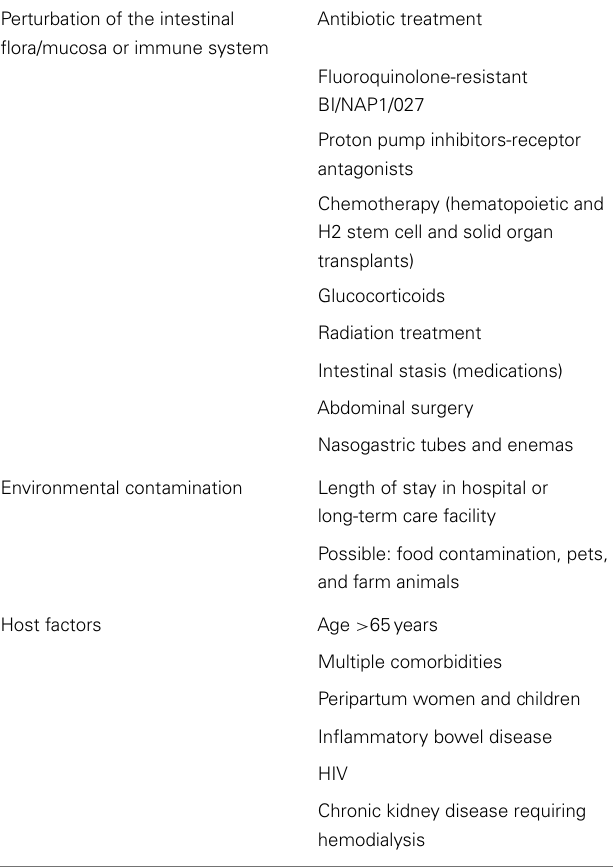
Table 3 | Risk factors associated with CDAD